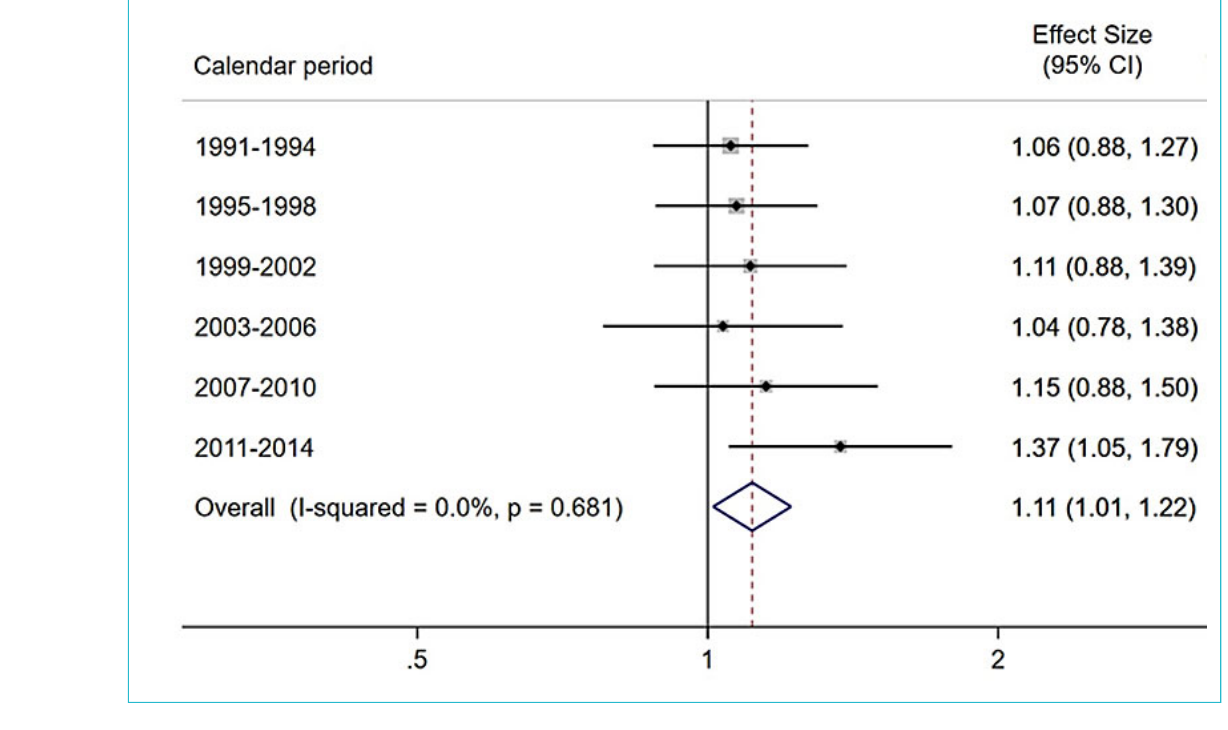
Figure 3: Standardised mortality ratios comparing suicide rates in male farmers with all the men included in the study (95% confidence inter- vals), per time period and over all calendar